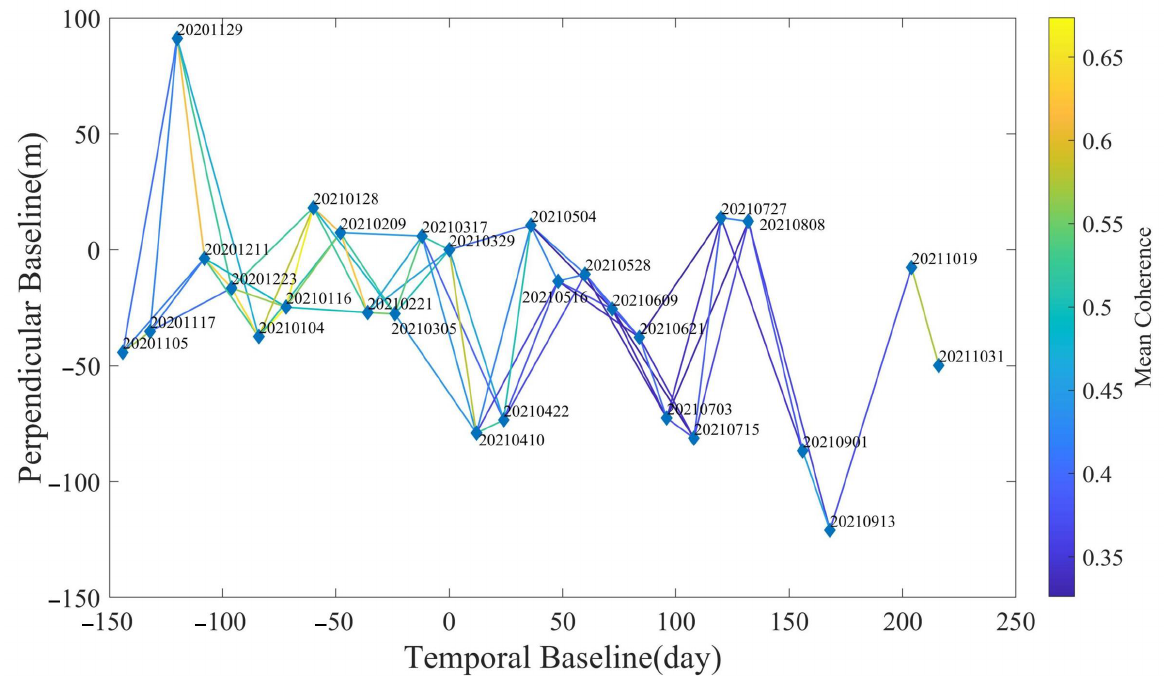
Figure 2. Spatiotemporal baseline and mean coherence value of differential interferograms. The color of line indicates the mean coherence of differential interferogram produced by data pair.